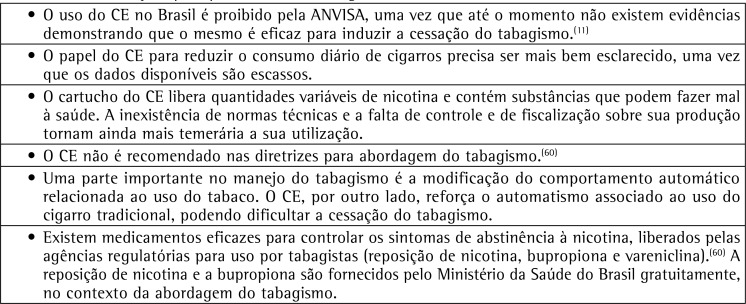
Orientações para pacientes sobre o cigarro eletrônico. CE: cigarro
eletrônico; e ANVISA: Agência Nacional de Vigilância Sanitária.